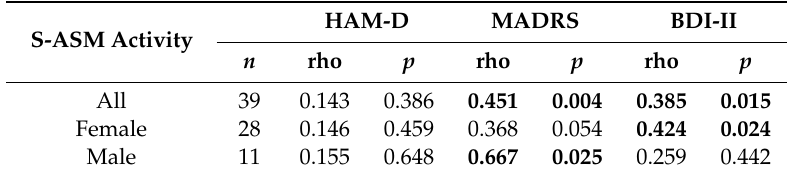
Table 2. Positive correlation of serum acid sphingomyelinase (S-ASM) activity with depression severity scores at inclusion as assessed by rating by a clinician (HAM-D and MADRS) and self-rating (BDI-II) in patients with remitted major depressive disorder.